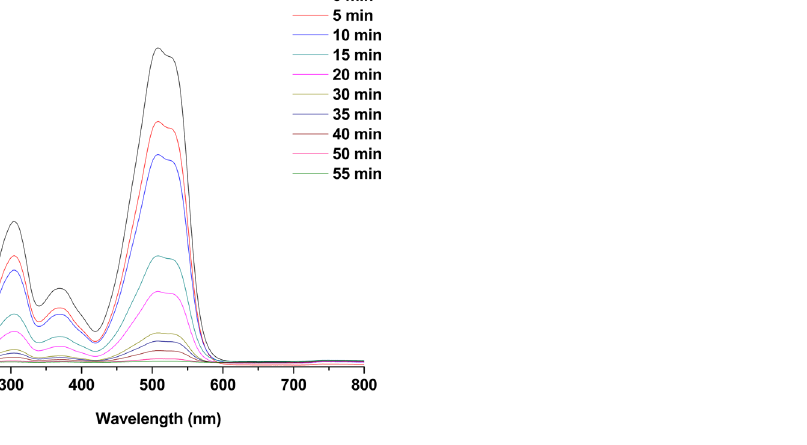
Figure 5. UV-vis absorption spectra of Chromotrope 2R degradation with time catalyzed by Au(Salen)@CC